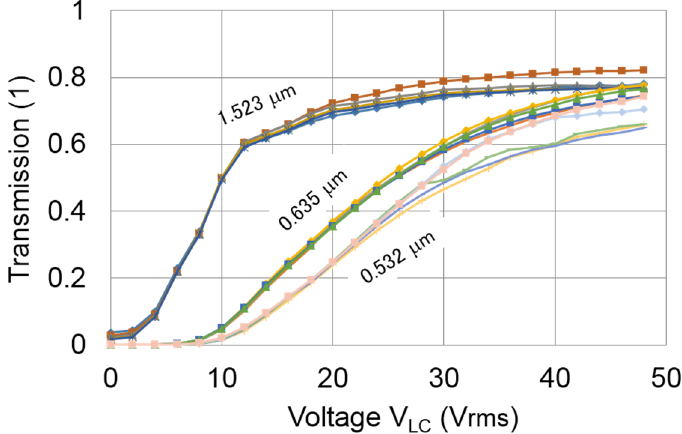
Figure 4. Transmission dependence on the applied voltage V LC . The measurement was done at the solid angles between 7.9 × 10 − 5 (lowest) and 2.0 × 10 − 3 (highest) steradians and at the wavelengths of 0.532, 0.635, and 1.523 μ m. Sample: SIR132.